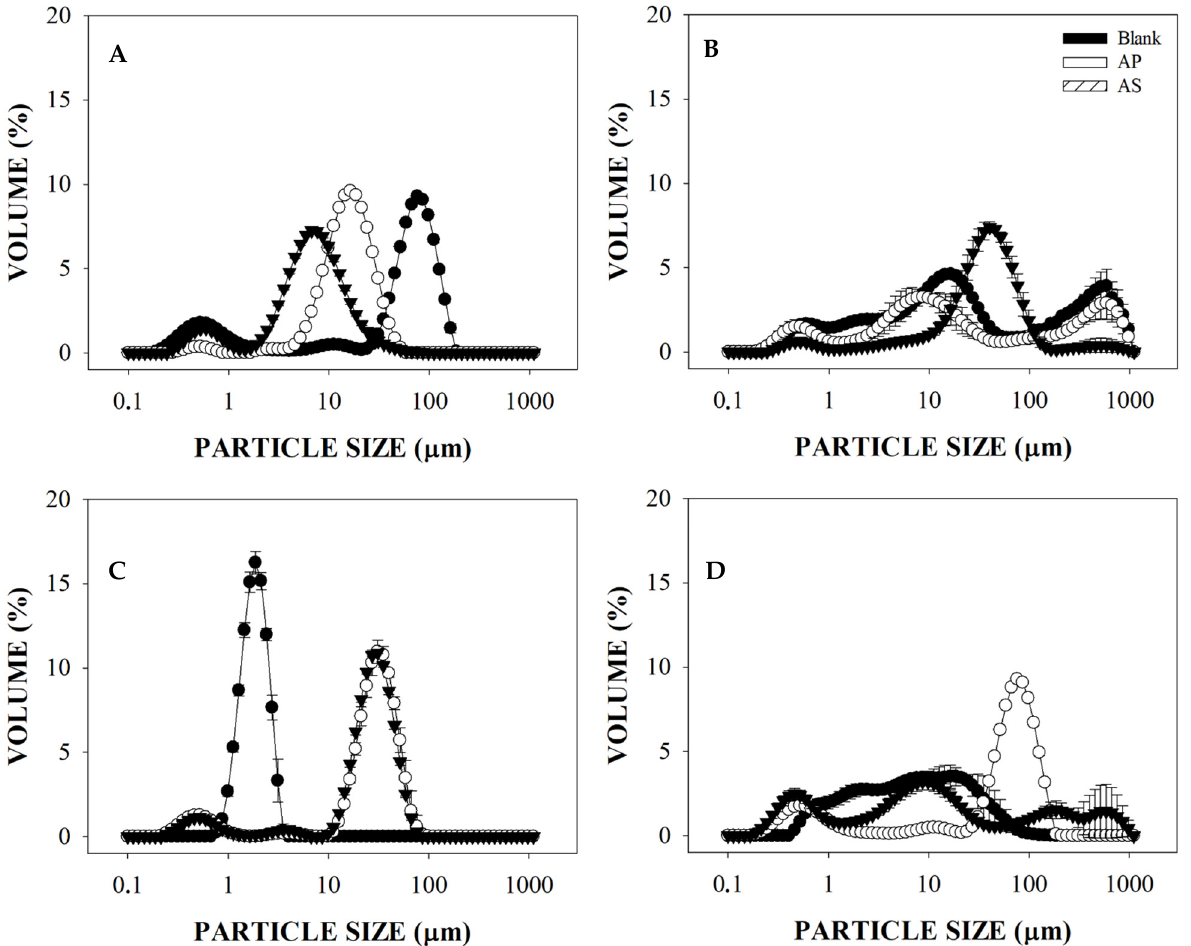
Figure 3. Effect of low methoxyl pectin (LMP) on the particle size distribution of oil-in-water (O/W) emulsions, with or without avocado peel and seed extracts, during simulated gastric ( A , C ) and intestinal ( B , D ) digestion conditions. ( A , B ) = O/W dispersions; ( C , D ) = Emulsions containing LMP.